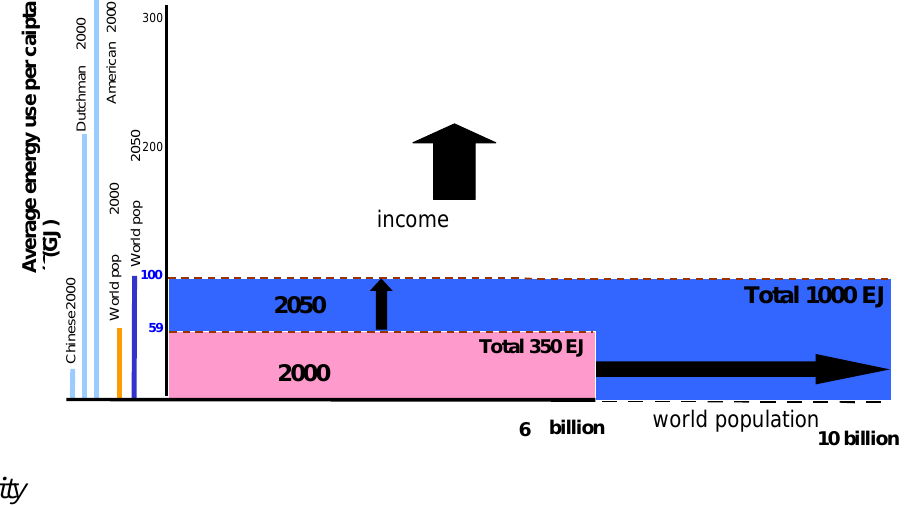
Figure 1. Increase in world energy use. The area in pink indicates world energy consumption in 2000; the area in blue indicates the expected world energy consumption in